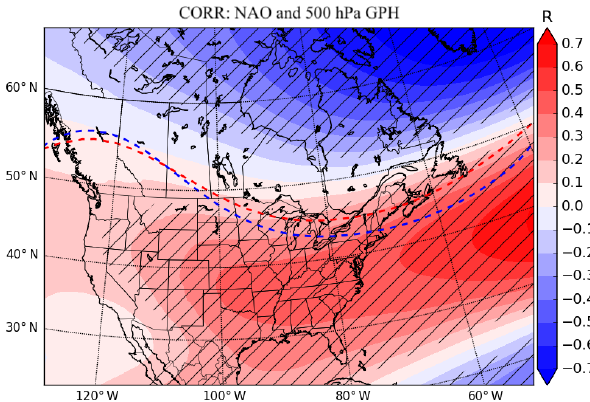
Figure 9. Correlation coefficients between monthly 500hPa geopo- tential heights and monthly NAOI in winter (DJFM). Hatched areas represent statistically significant values at the 0.05 level. Dashed lines represent the average position of the 5400m geopotential height isohypse during average low-NAO months (blue) and aver- age high-NAO months